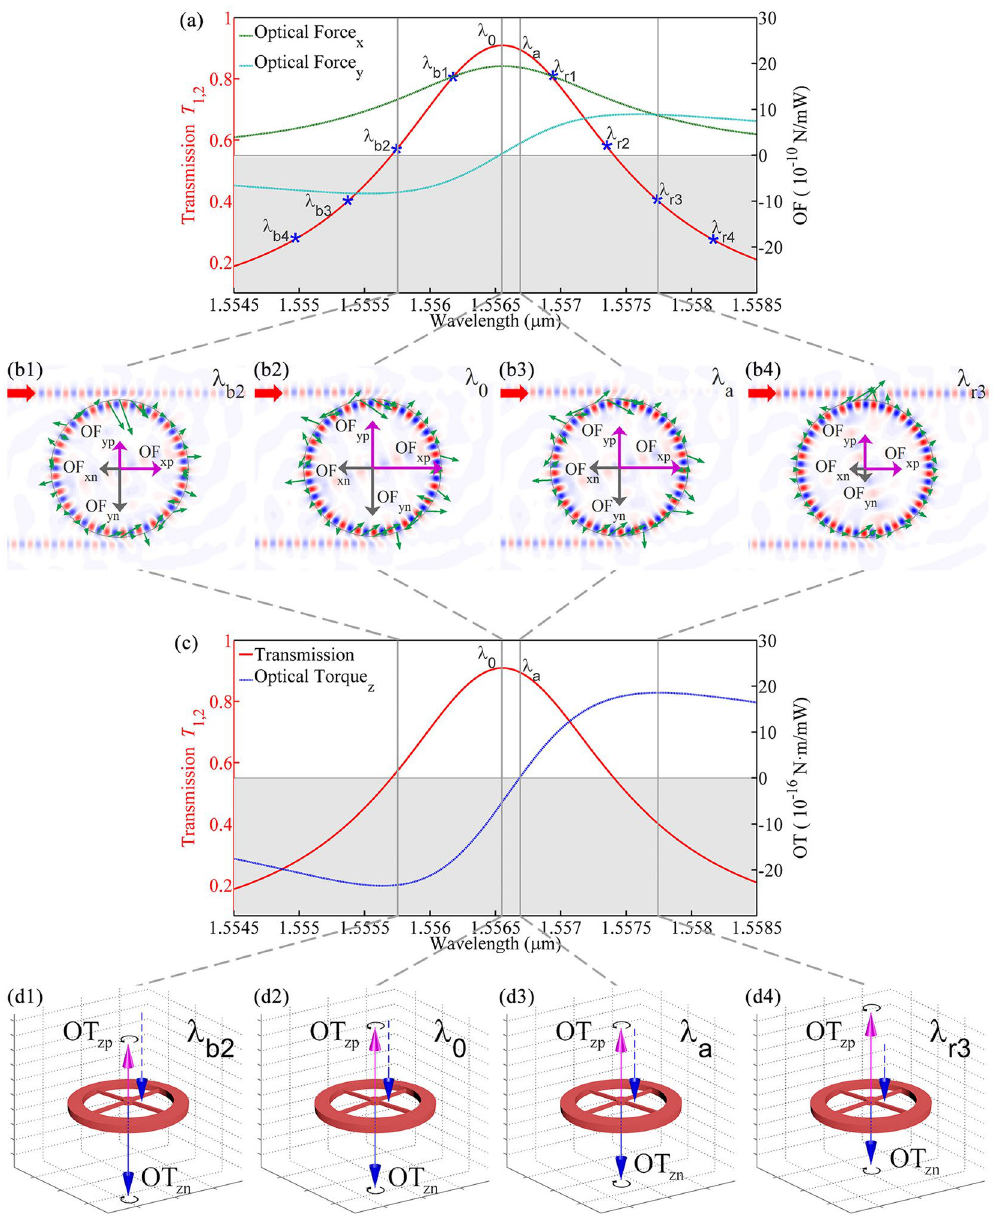
Figure 2. Optical force and torque on the ring resonator when it is located at (0,0), and only port 1 is excited. ( a ) Transmission spectrum T 1,2 of the system (left y -axis, red solid curve) and the x , y components of the optical forces (right y -axis, green color for x component, and cyan color for y component) exerted on the ring resonator. The four gray vertical solid lines represent four typical wavelengths λ b2 , λ 0 , λ a , λ r 3 (resonant wavelength is λ 0 ) and the eight blue star labels represent different extent excitation wavelengths that λ b 1– b 4 ( λ r 1– r 4 ) are the blue (red) detuned wavelength, which are analyzed detailedly in the following sections. ( b1 ~ b4 ) Distribution of electric field E z and optical force density vector on the integral path (green arrows) overlapped by the positive and negative components of the optical forces in x and y directions, respectively (denoted by OF xp , OF xn , OF yp and OF yn , respectively). ( c ) Optical torque exerted on the ring resonator (right y -axis, blue dotted curve). The transmission curve (left y -axis, red solid curve) is also drawn for reference. Here, negative (positive) OT means clockwise (anti-clockwise) rotation of the ring resonator. ( d1 – d4 ) Relative values of the positive and negative components of OT. For comparison, the blue arrows are also shown next to the red